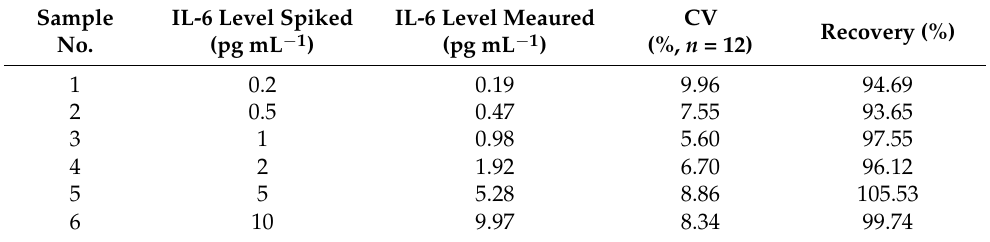
Table 2. Analytical recoveries of Pd@Pt ND ELISA in detecting IL-6-spiked human serum samples.